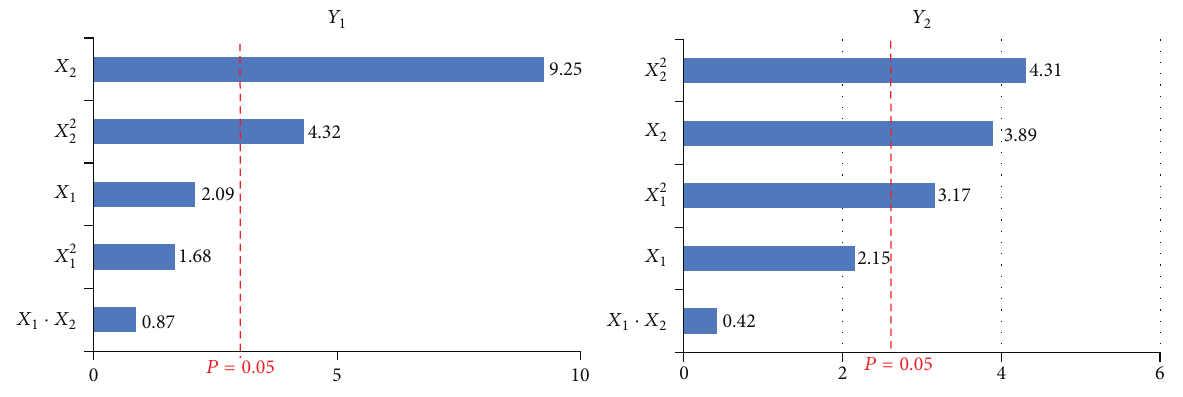
Figure 4: Pareto charts of 𝑌 1 (flexural strength) and 𝑌 2 (split tensile strength).